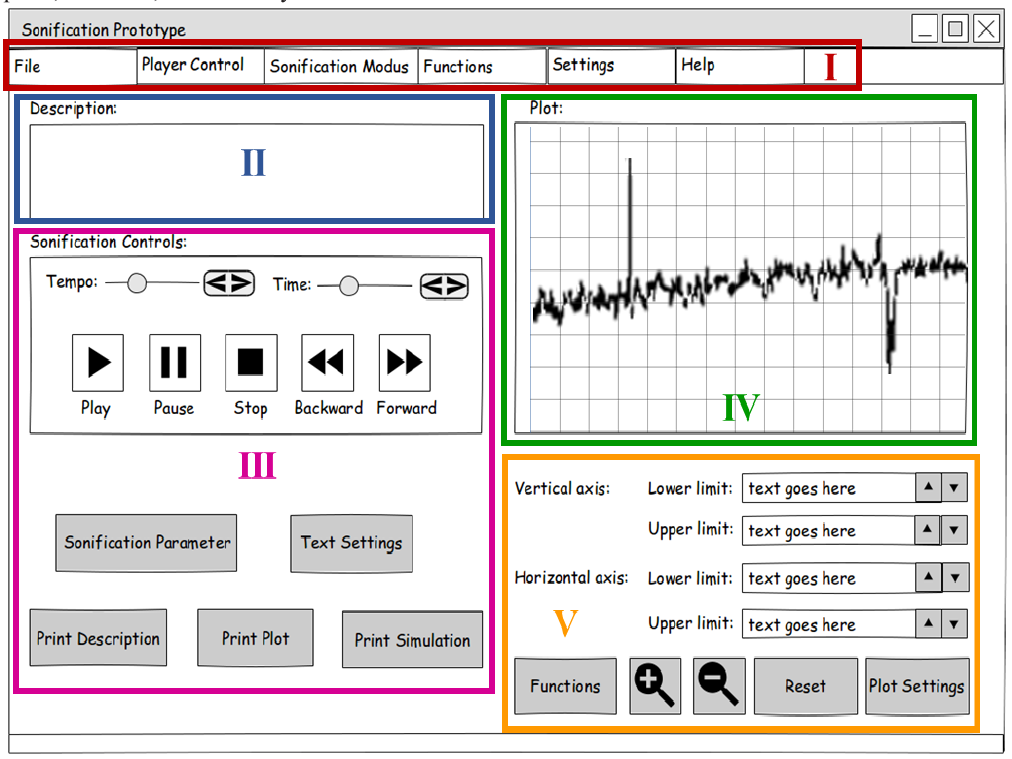
Figure 3. Pictorialization/illustration of sonification program